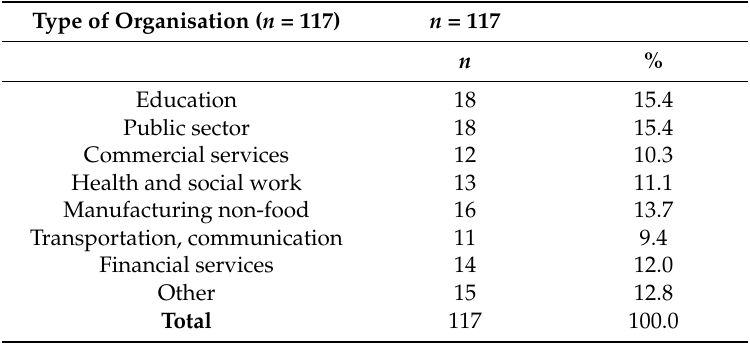
Table 3. Background information on students that participated in the study—Type of organization. Type of Organisation ( n =